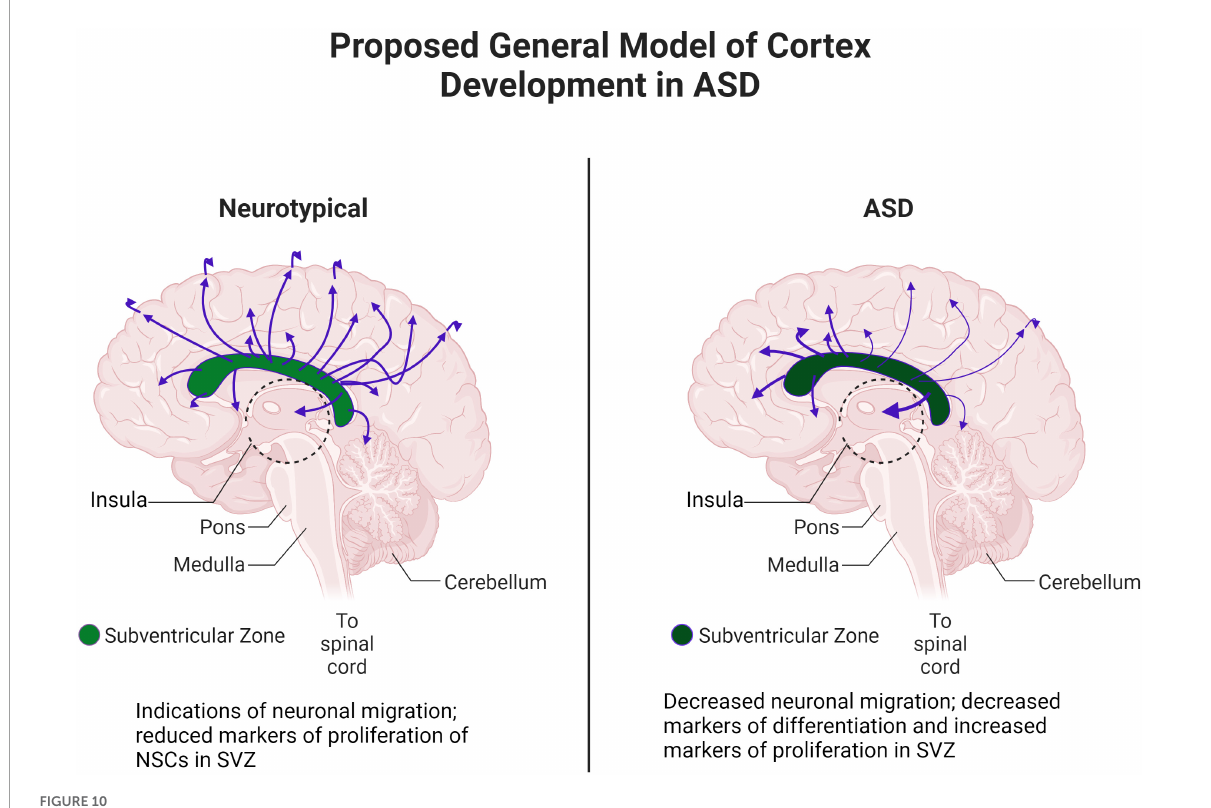
FIGURE10 Proposed general model of cortex development in ASD. Adapted from “Distribution of Histamine and Serotonin Neurotransmitters in the Human Brain” by BioRender.com (2022). Retrieved from